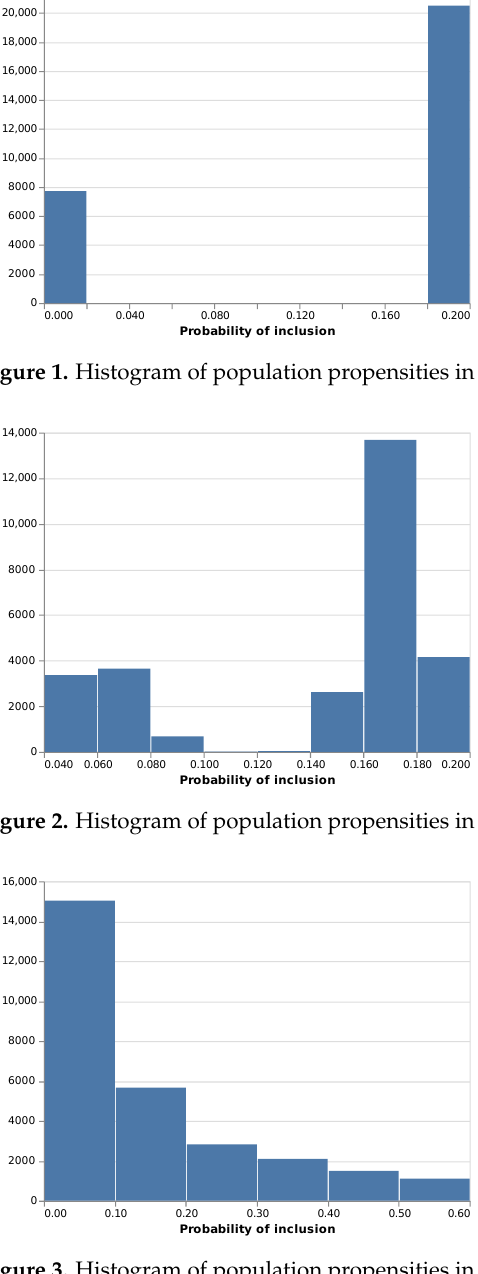
Figure 3. Histogram of population propensities in